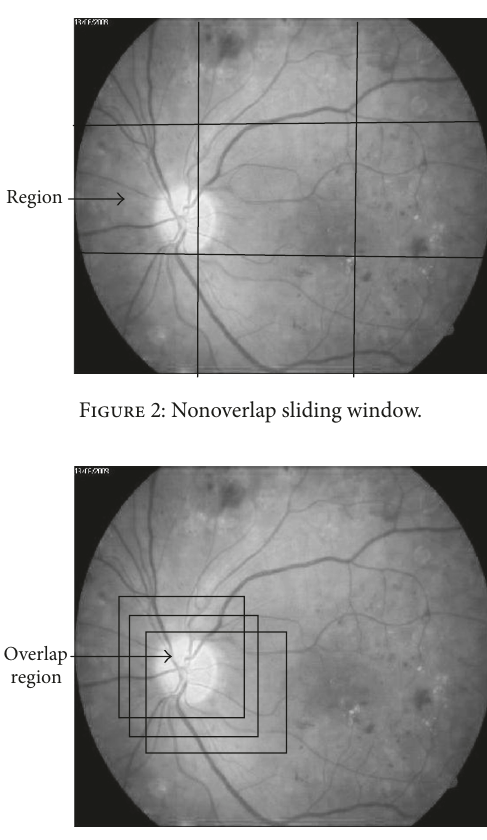
Figure 3: Overlap sliding